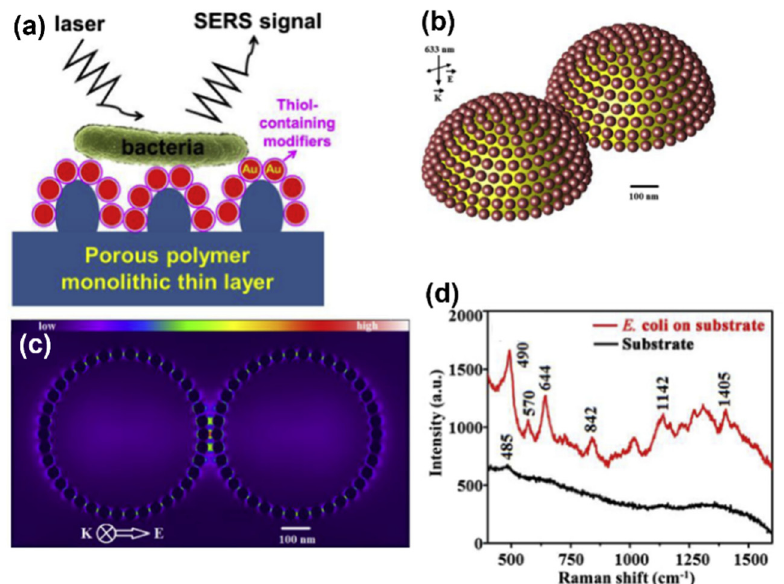
Figure 4. Schematic and detection principle of GNP/monolith modified substrate for the capture of E. coli . ( a ) Cross-sectional view of E. coli captured on gold nanoparticles modified substrates. ( b ) SERS enhancement factor of porous substrate functionalized with 40 nm gold nanoparticles simulated by FDTD. ( c ) In the simulation, the geometry of the model is reduced to two hemispheres coated with 40 nm spherical gold nanoparticles, separated by 10 nm; the electric field intensity distributions in x-y plane and y-z plane of gold on porous monolithic substrate excited by 633 nm laser are calculated. ( d ) SERS spectra of 40 nm gold nanoparticles/substrate functionalized with cysteamine [98]. Adapted with permission from Ref. [98]. Copyright © 2015 Elsevier B.V.